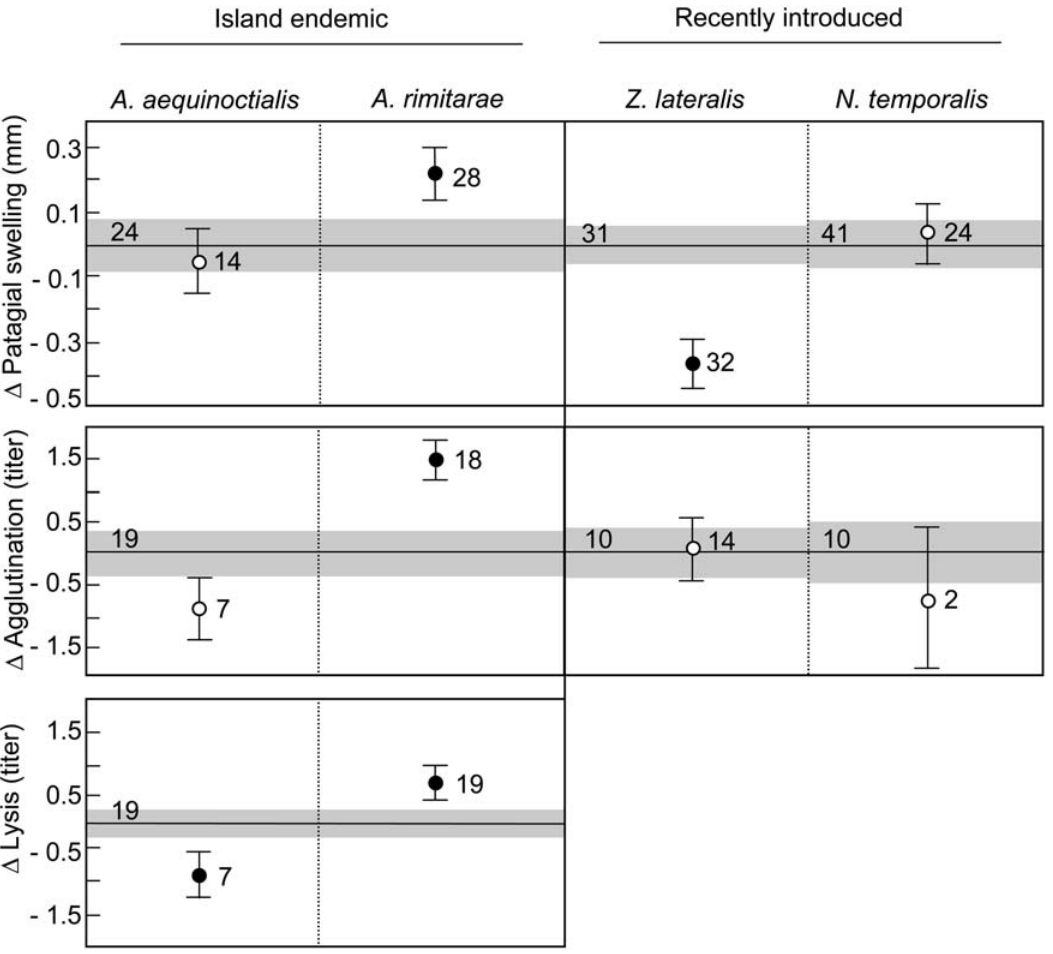
Figure 3. Immune response of island taxa relative to a mainland counterpart. Cell-mediated (PHA-induced patagial swelling) and constitutive innate (agglutination and lysis of rabbit red blood cells) measures of immune response in endemic and recently-introduced island taxa (circles) are indicated relative to control values (centered at zero) from a closely-related mainland taxon. Numbers indicate sample size and standard error is depicted by vertical bars, or by grey shading in the case of the mainland control. Filled circles indicate a significant difference from the mainland control.